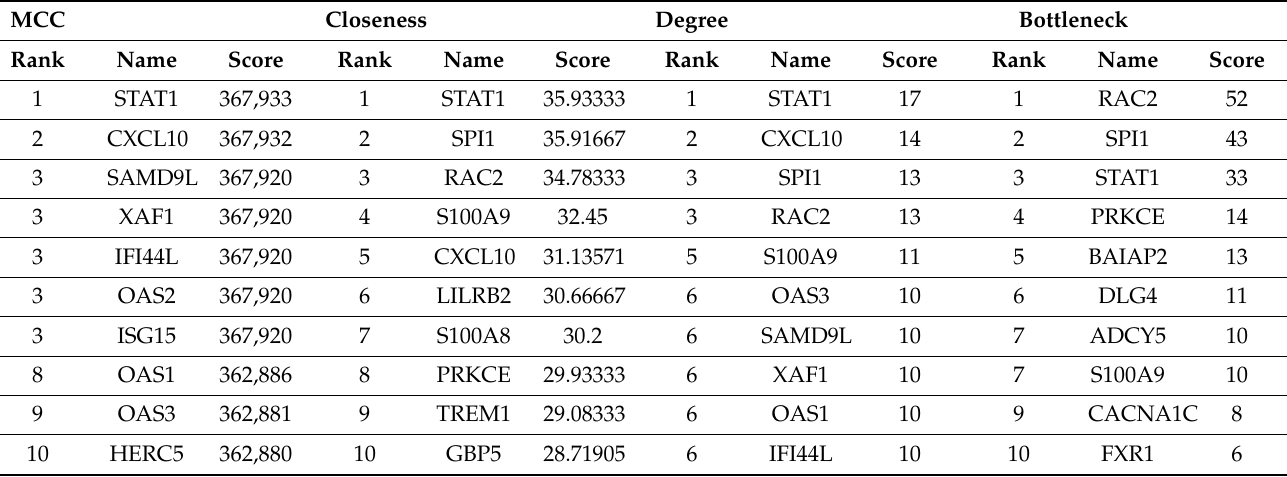
Figure 3. Protein–protein interaction network of DEGs. ( A ) A total of 203 nodes and 346 interaction associations were identified. The nodes with the highest PPI scores were shaped as the diamond in yellow. ( B ) The most significant module from the PPI network and their best nearby interaction. ( C ) Important Hub genes. Table 3. Top 10 differentially expressed genes with their weight scores based on four centrality